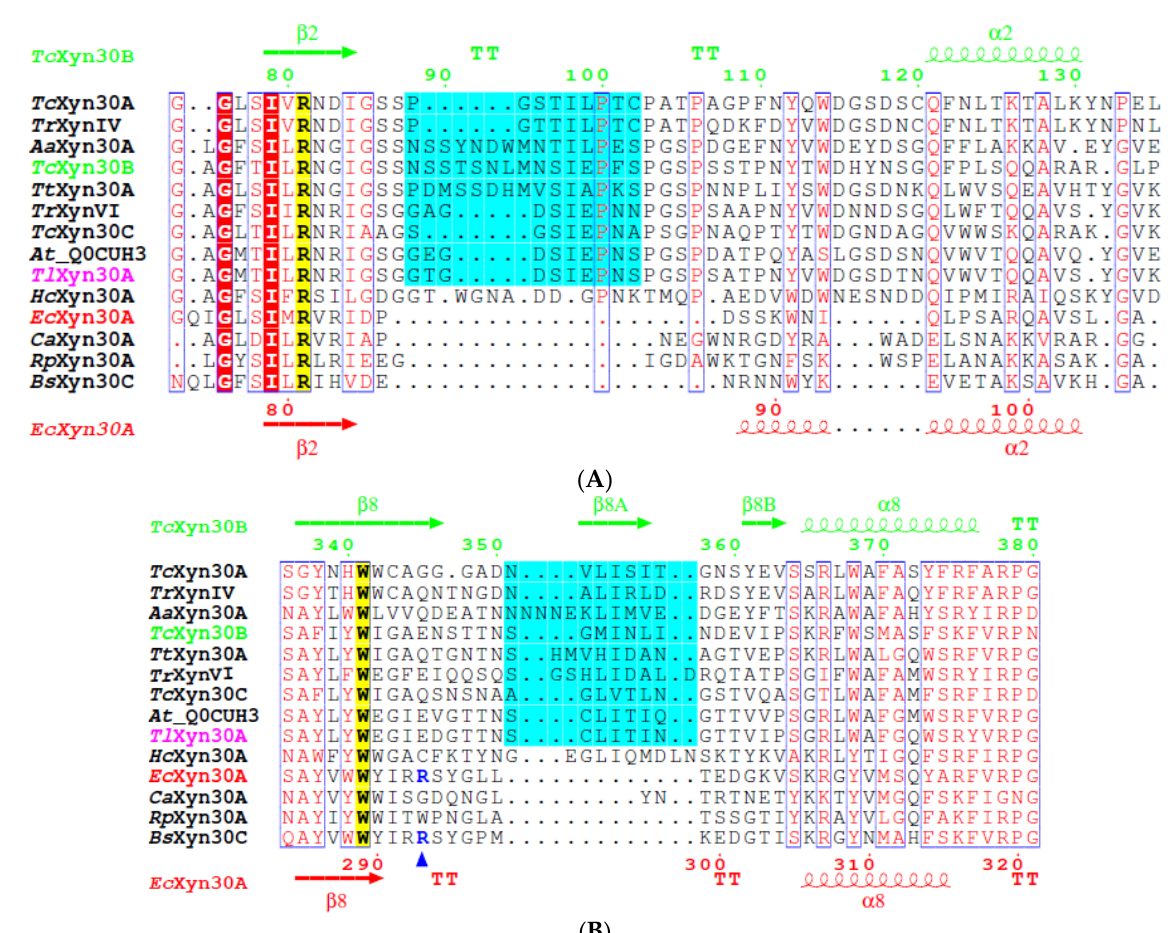
Figure 6. Multiple sequence alignment of Tl Xyn30A and selected GH30 xylanases. The first two sequences, Tc Xyn30A (Uniprot ID: A0A0B8MZ29) and Tr XynIV (A0A024RWW9), represent reducing-end xylose-releasing enzymes. For